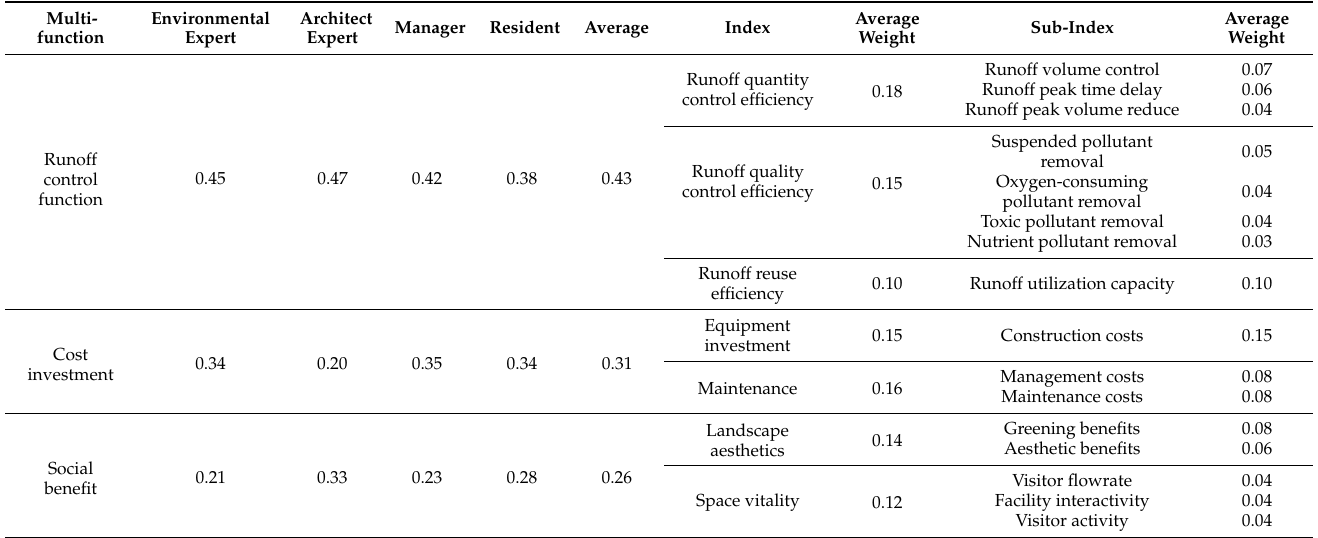
Table 5. Weights for the GI multifunctional